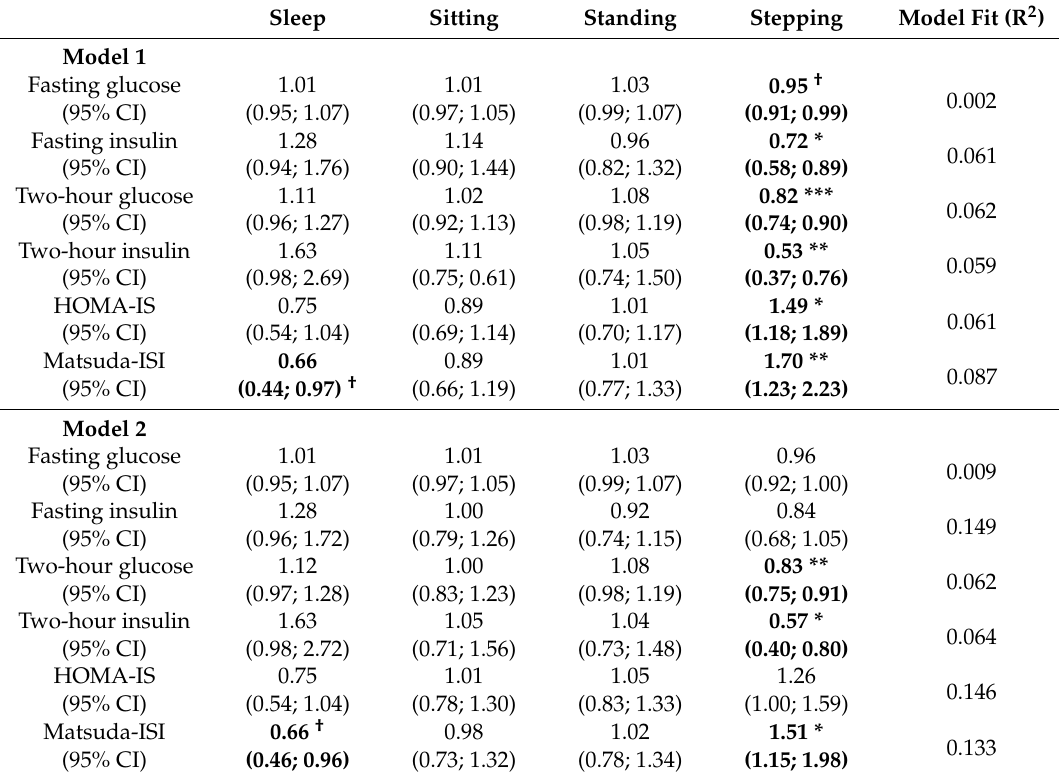
Table 4. Compositional linear models showing the association between time spent in different physical behaviours and metabolic biomarkers. Sleep Sitting Standing Stepping Model Fit (R 2